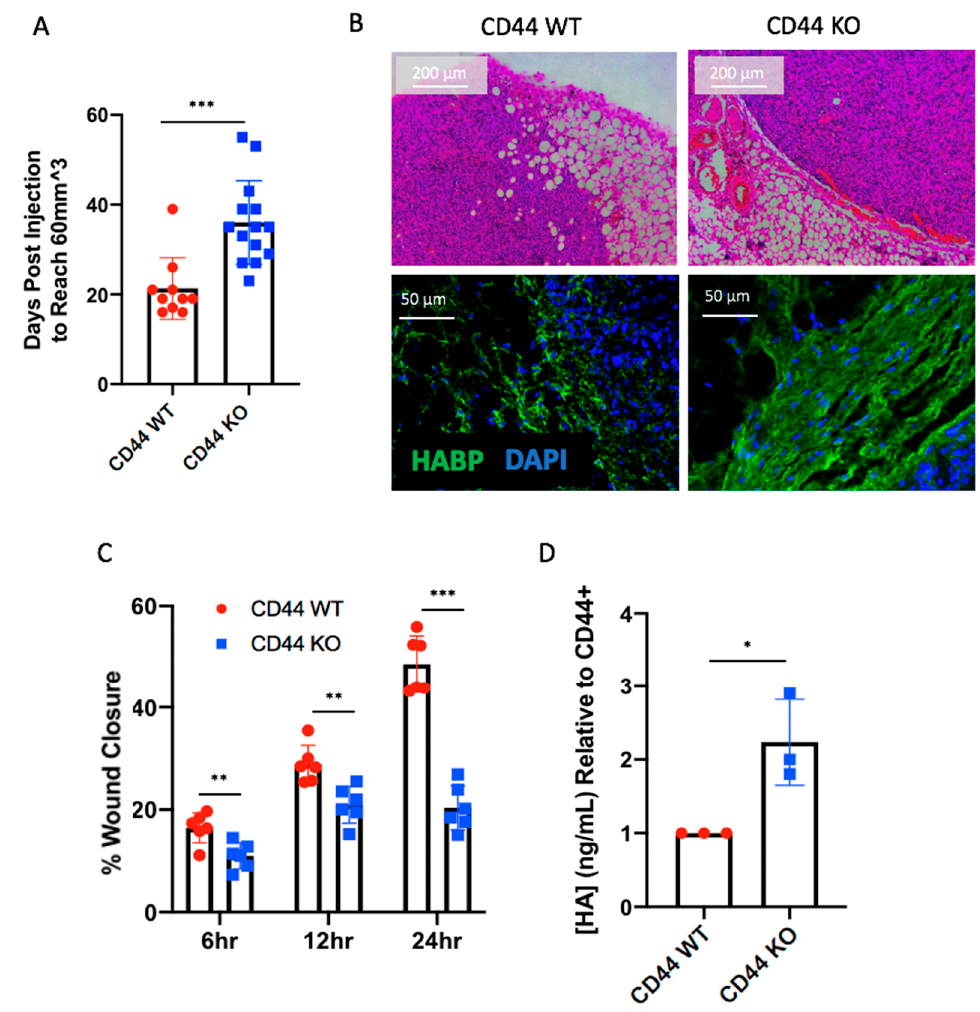
Figure 5. CD44 deletion in Hs578T cells delays early tumor formation. ( A ) Number of days that Hs578T CD44 WT tumors ( n = 10) and CD44 KO tumors ( n = 14) took to form palpable lesions within the mammary fat pad of athymic nude mice. ( B ) Histological analysis of early tumors using H&E and immunofluorescence to identify HA in green (using hyaluronic acid binding protein), and nuclei in blue (using DAPI). Images were acquired on a Leica DM400B microscope, at either 100× or 400× magnification. ( C ) Scratch wound assay analyzing wound closure in vitro in Hs578T CD44 WT compared to CD44 KO cells at 6, 12, and 24 h time points. ( D ) HA production in vitro quantified via ELISA within CD44 WT and KO Hs578T cells. Experiments were repeated at least three times, represented by each data point. Statistical analysis was performed using Student’s unpaired, two-tailed t -test. Error bars represent standard error of the mean. P values * p < 0.05; ** p < 0.01; *** p < 0.001.